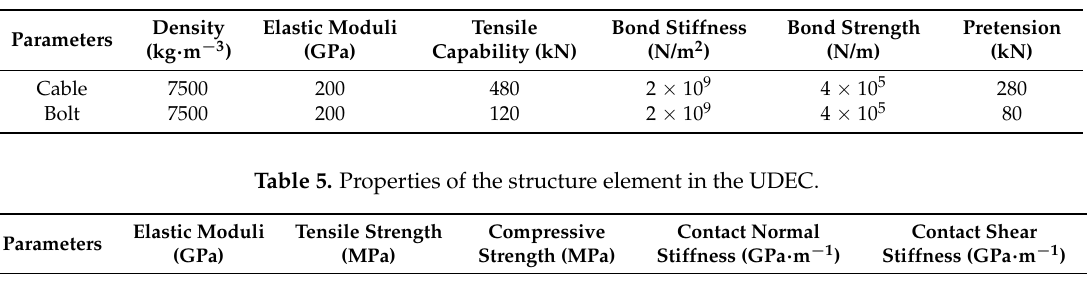
Table 4. Properties of the bolt and cable elements used in the UDEC.